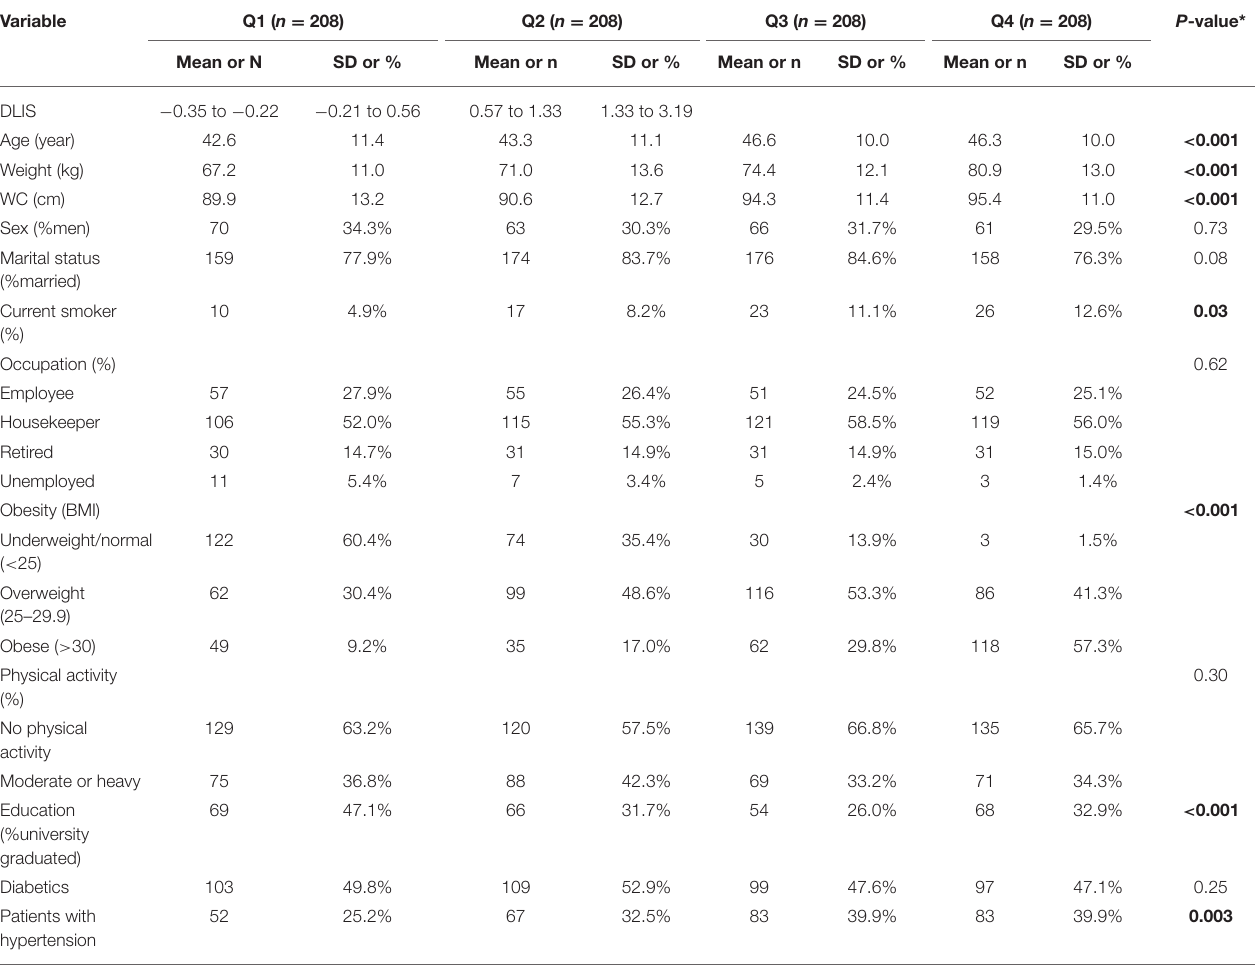
TABLE 1 | Sociodemographic characteristic of the study participants across quartile of the DLIS in Tehranian adults.